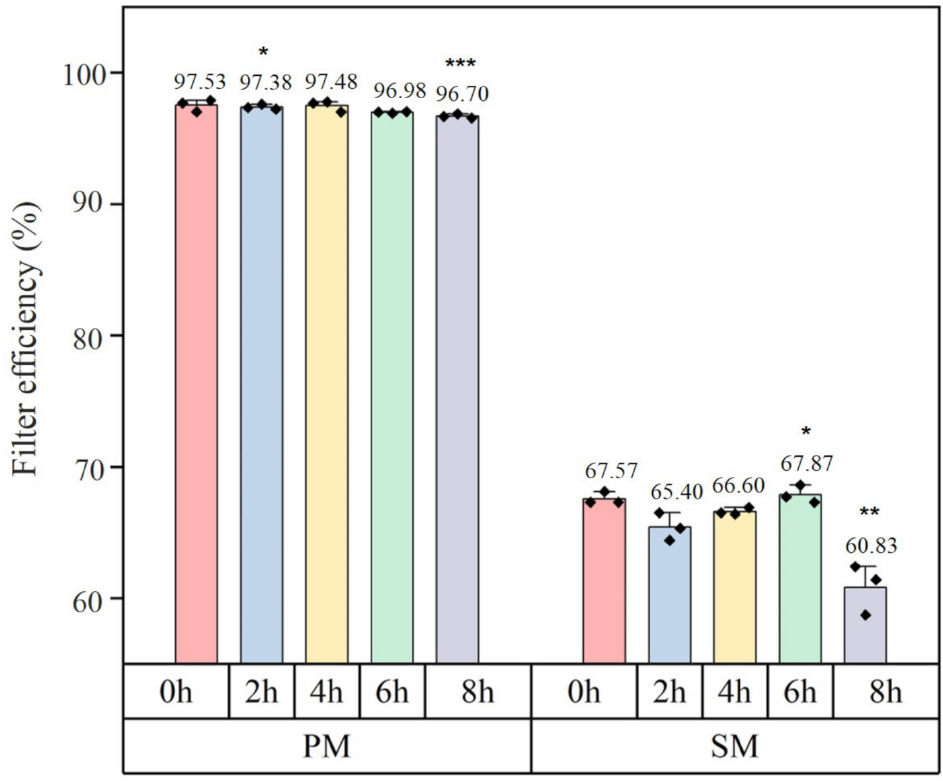
Figure 3. Results of filtration efficiency on particulate matter. (cid:117) represents a data point. *: p value < 0.05, **: p value < 0.01, ***: p value <